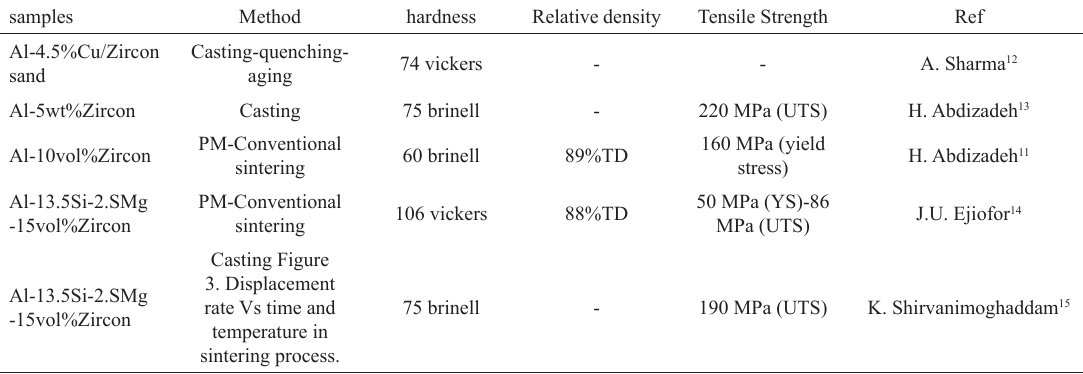
Table 2: Mechanical properties and relative density of Al-Zircon composite investigated by other researchers.